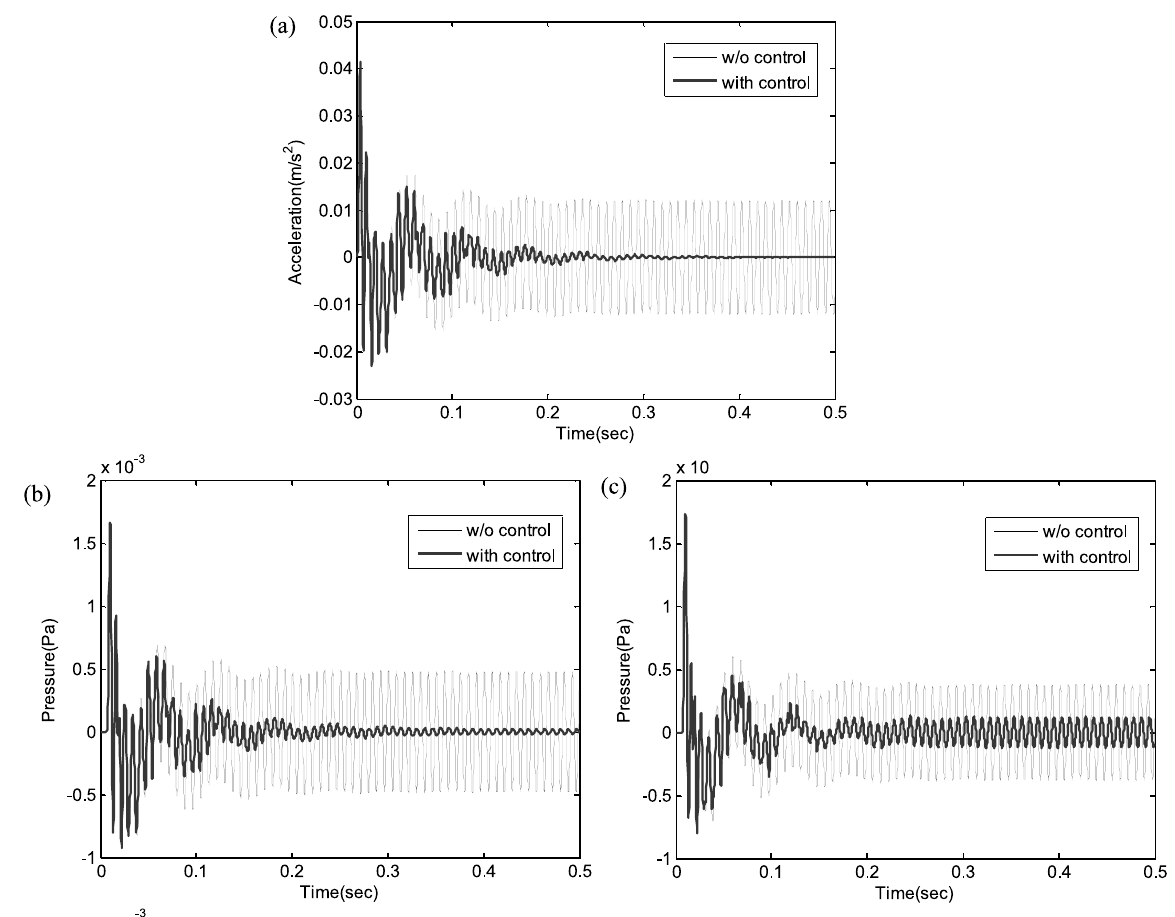
Fig. 7. Acceleration responses and radiated sound pressure ( r = 10 / √ 3 ), a) summed acceleration; b) sound pressure at (0, 0, 10) m; c) sound pressure at (r, r, r)